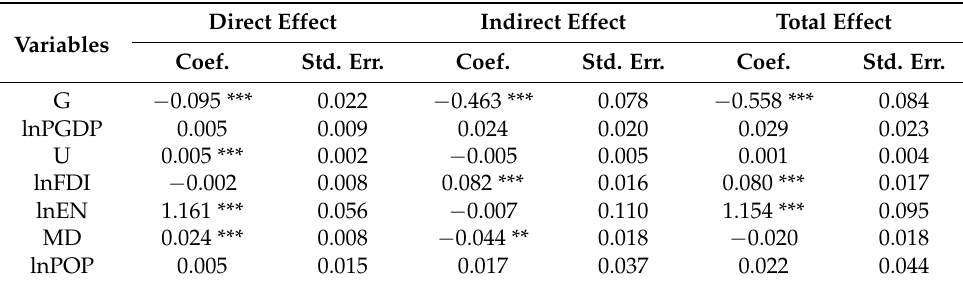
Table 7. Direct effect, indirect effect, and the total effect of SDM. Direct Effect Indirect Effect Variables